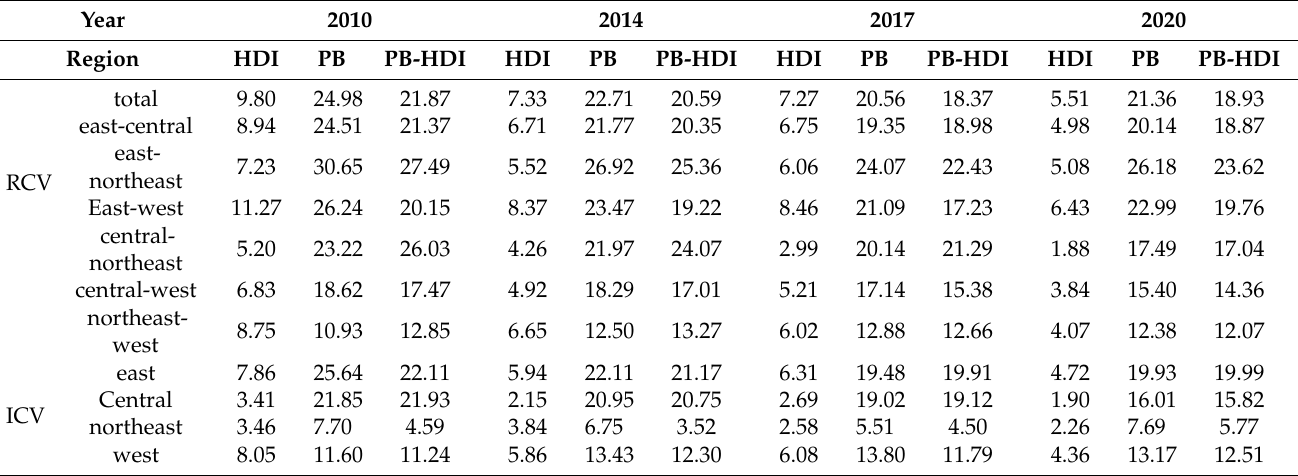
Table 4. Regional variation coefficient (%).